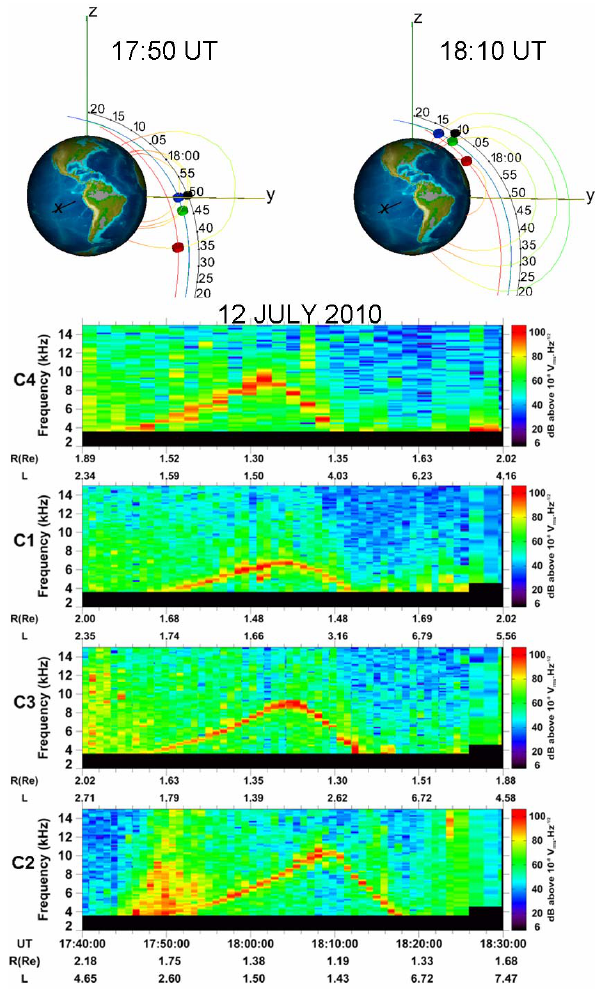
Fig. 3. 12 July 2010 event. Top: CLUSTER orbits in the SM coor- Figure 3. July 12th 2010 event. dinate system. Views produced by OVT tool. Bottom: WHISPER Top: CLUSTER orbits in the SM coordinate system. Views produced by OVT tool spectrograms focused on lower hybrid resonances (active spectra Bottom: WHISPER spectrograms focused on lower hybrid resonances (active spectra only). . only).